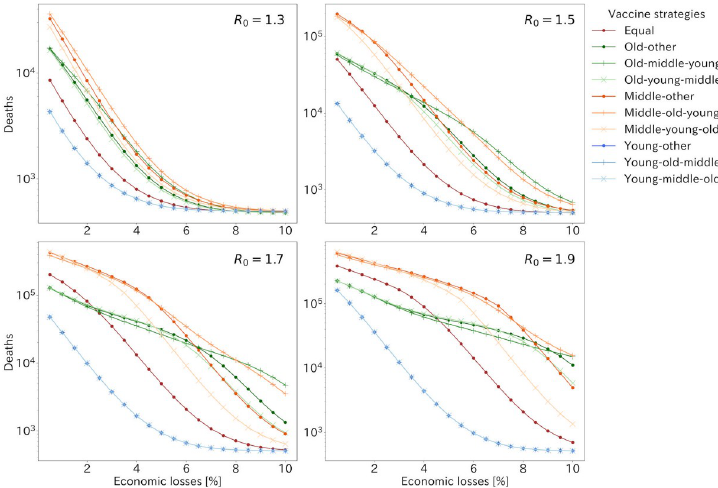
Fig 4. The cumulative number of deaths with R0 taking 1.3, 1.5, 1.7 and 1.9 and ϕ = 0 when the lockdown was imposed equally to each generation. Each line shows vaccine allocation strategies. Three lines of young first vaccination strategies have overlain each